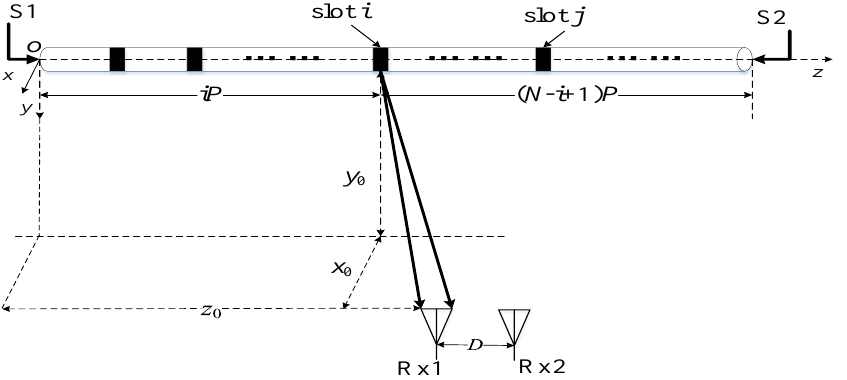
Figure 3. MIMO system with double-port fed of single LCX considering only an LoS path.